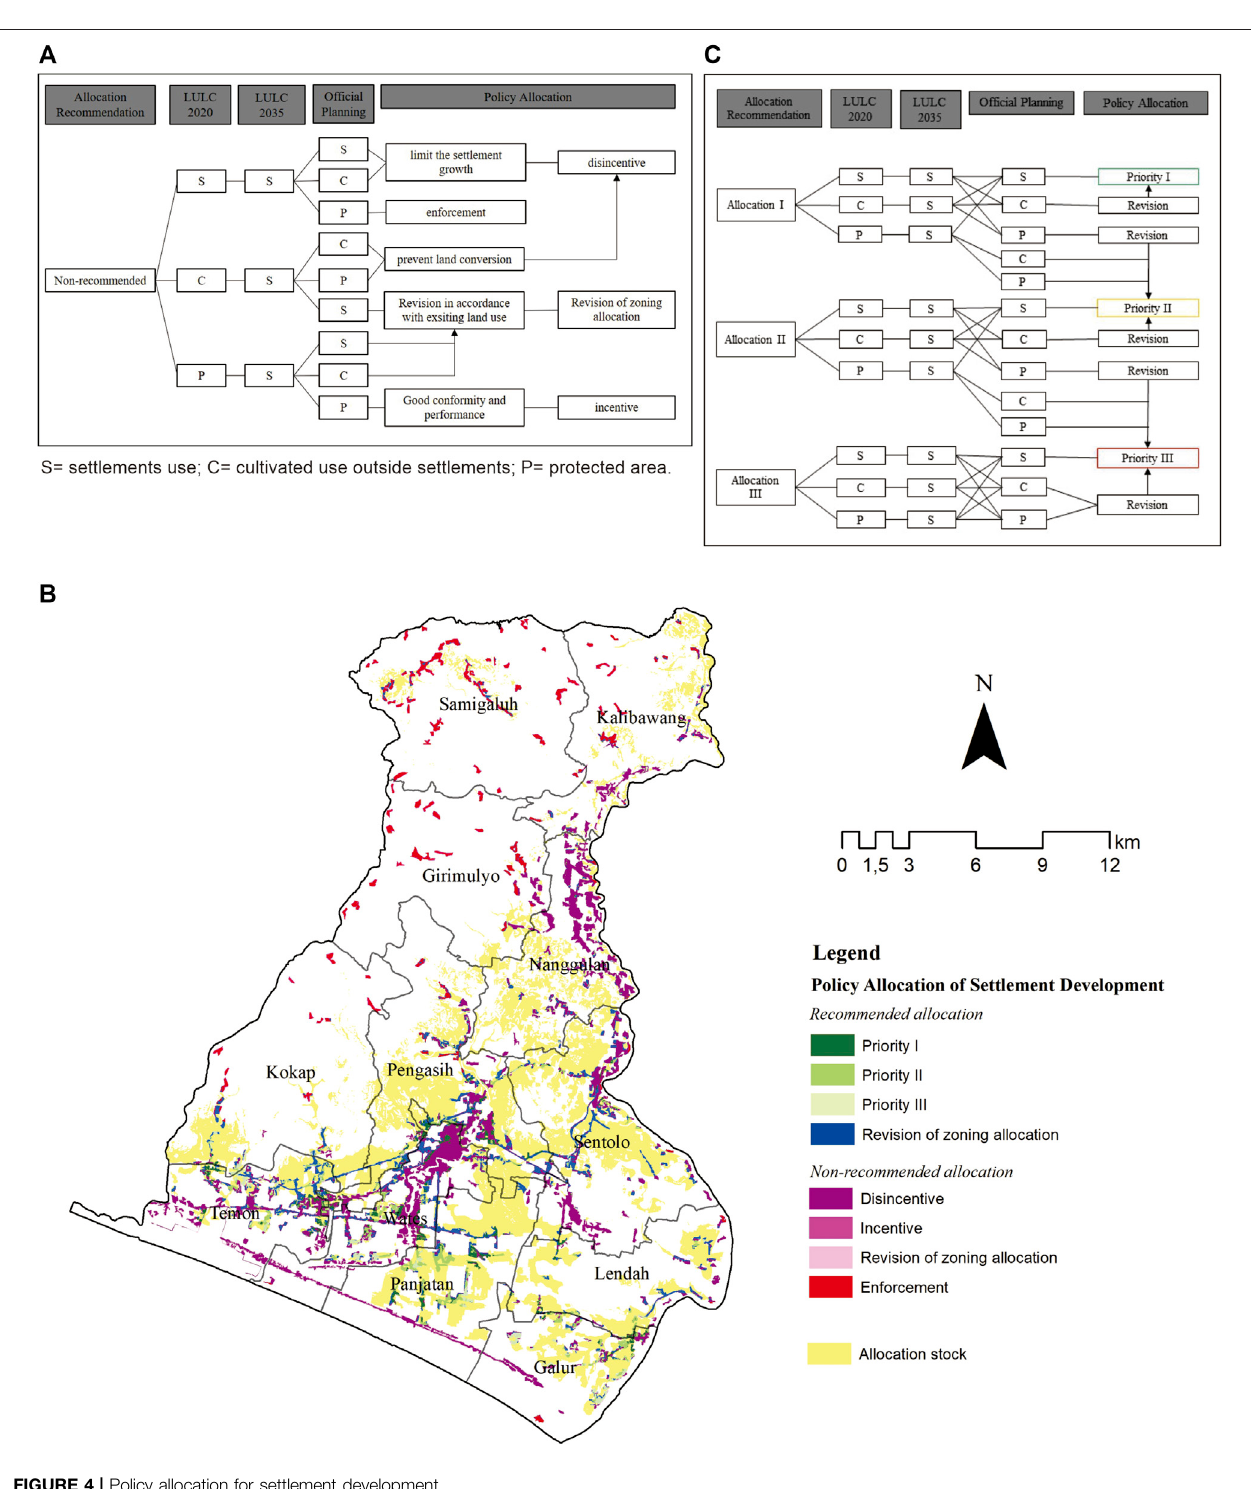
FIGURE 4 | Policy allocation for settlement